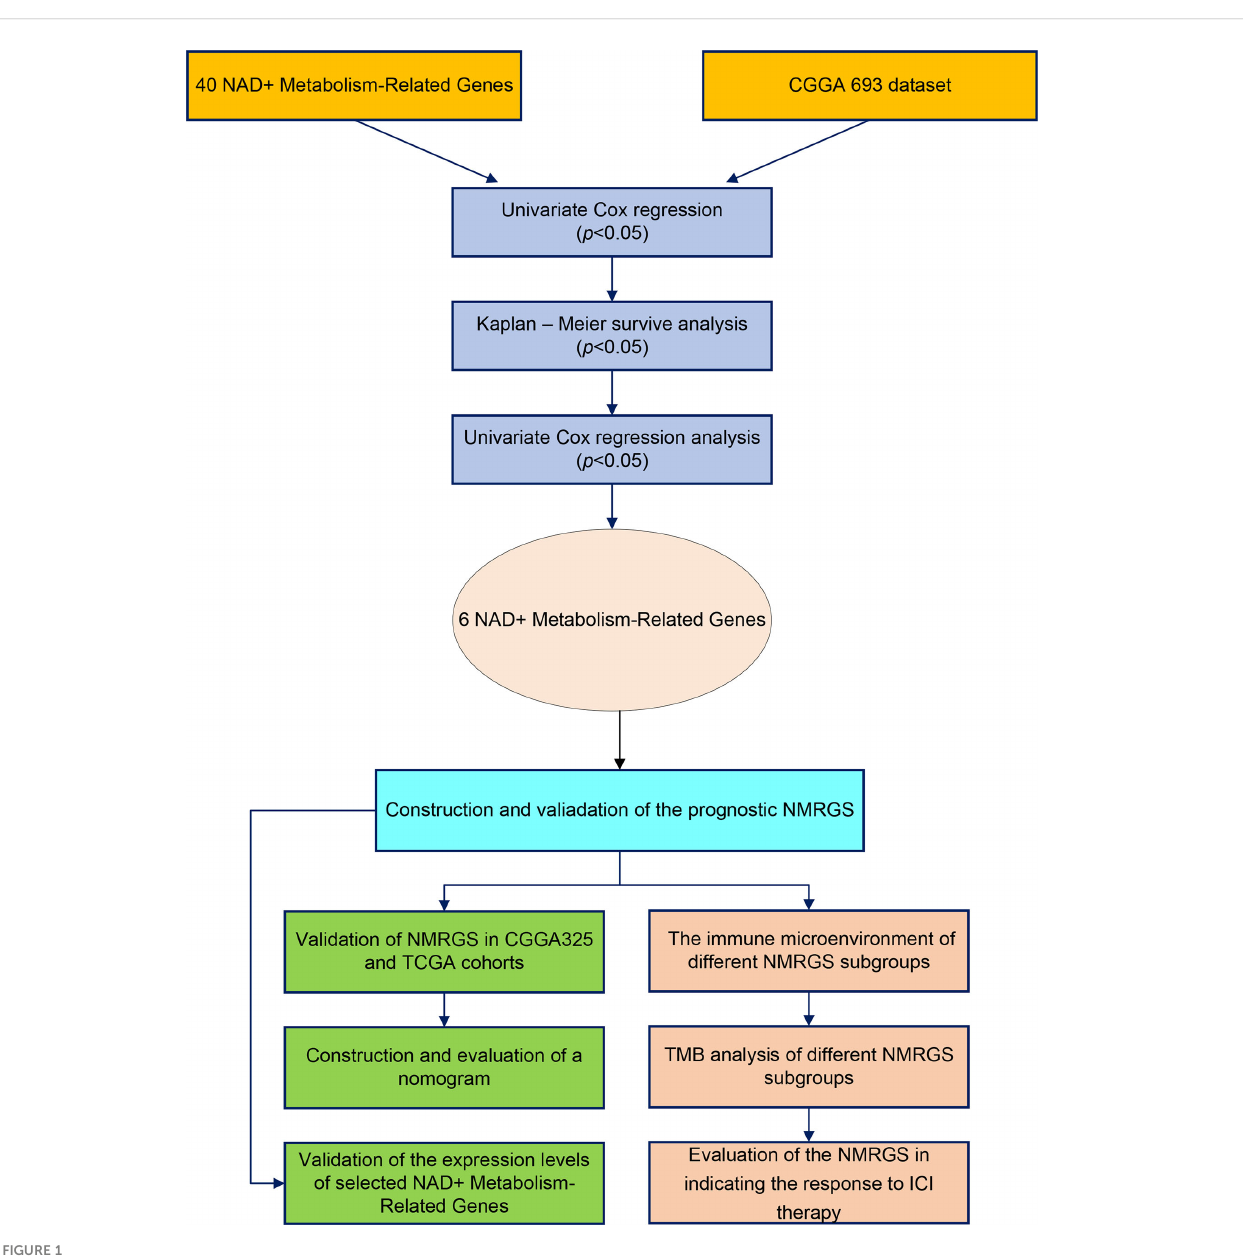
Figure S1. A comparison of expression levels of 40 NMRGs was made